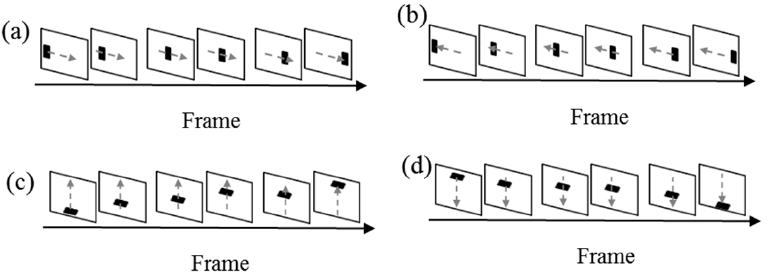
Figure 2. Schematic illustration of moving target. ( a ) The direction of motion was right. ( b ) The direction of motion was left. ( c ) The direction of motion was up. ( d ) The direction of motion was down.